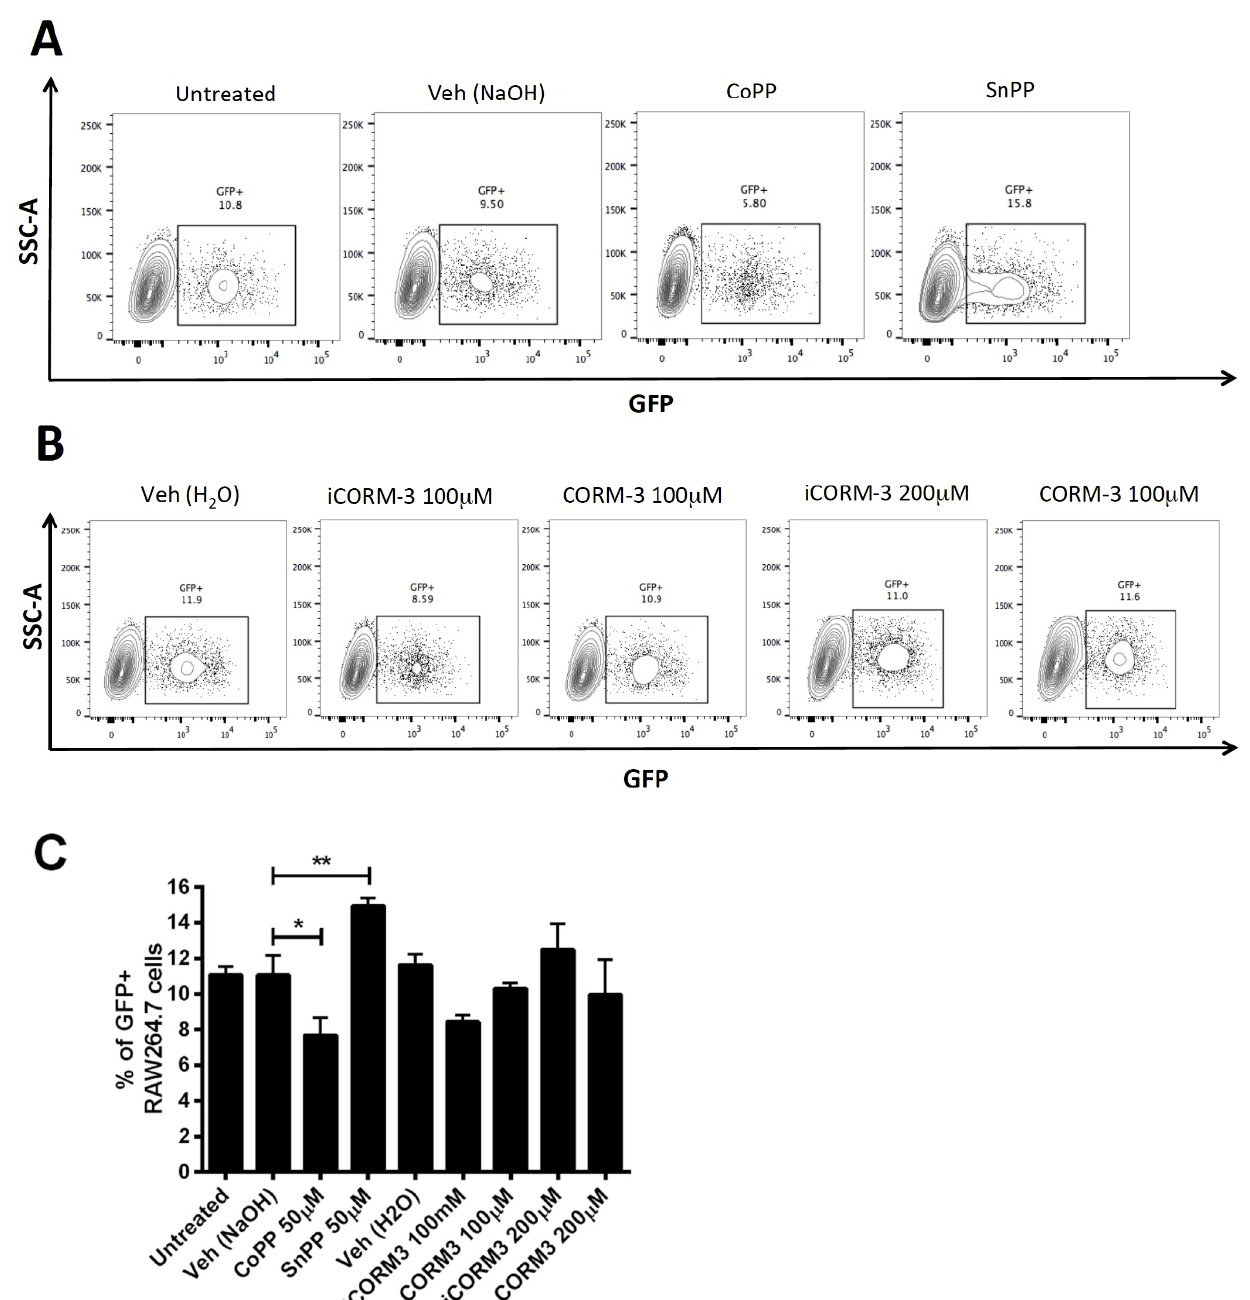
Figure 4. CoPP and SnPP treatment modulate S. Typhimurium survival in RAW264.7 cells in a CO-independent manner. RAW264.7 cells were infected with S. Typhimurium-GFP at MOI 25 for 1 h and treated with 100 µg/mL gentamicin for 1 h to kill extracellular bacteria. Cells were then treated with either vehicle (0.75 mM NaOH for CoPP and SnPP and dH 2 O for CORM3), CoPP 50 µM, SnPP 50 µM, CORM3 100 or 200 µM, or inactive CORM3 for 4 h. Cells were stained with a viability dye for flow cytometric analysis. ( A , B ). Representative dot plots are shown for each treatment. Results are presented as a percentage of live cells. ( C ). Mean of percentages for each treatment in two independent experiments. Differences were evaluated with one-way ANOVA, and significant ones are shown (*: p < 0.05; **: p < 0.005).